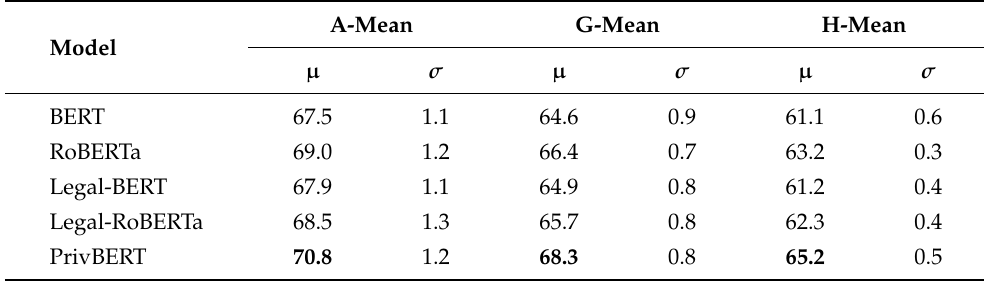
Table 3. Macro-aggregation of means ( µ ) and standard deviations ( σ ) per model using the arithmetic mean (A-Mean), geometric mean (G-Mean) and harmonic mean (H-Mean). A-Mean G-Mean Model